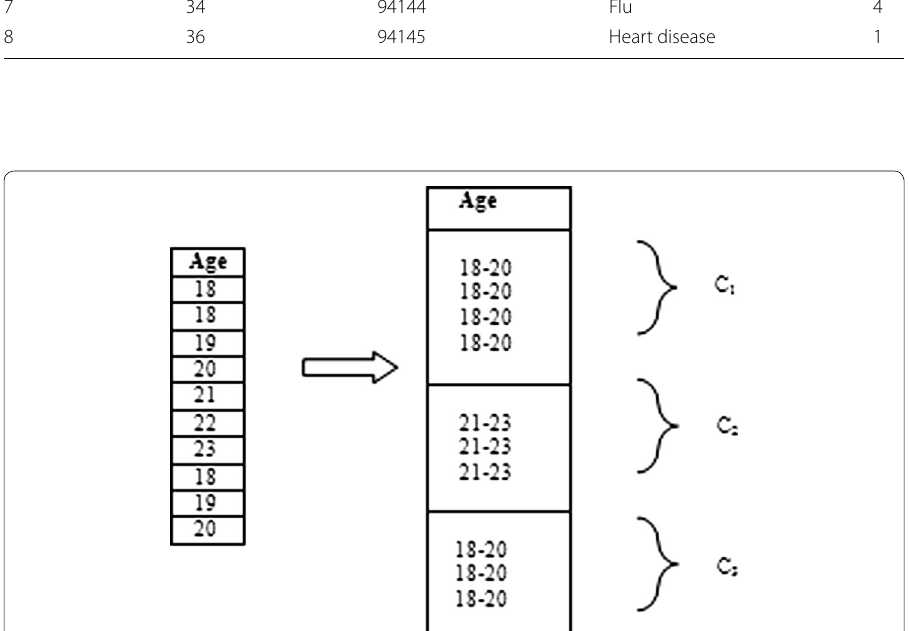
Fig. 2 Nearest similarity based